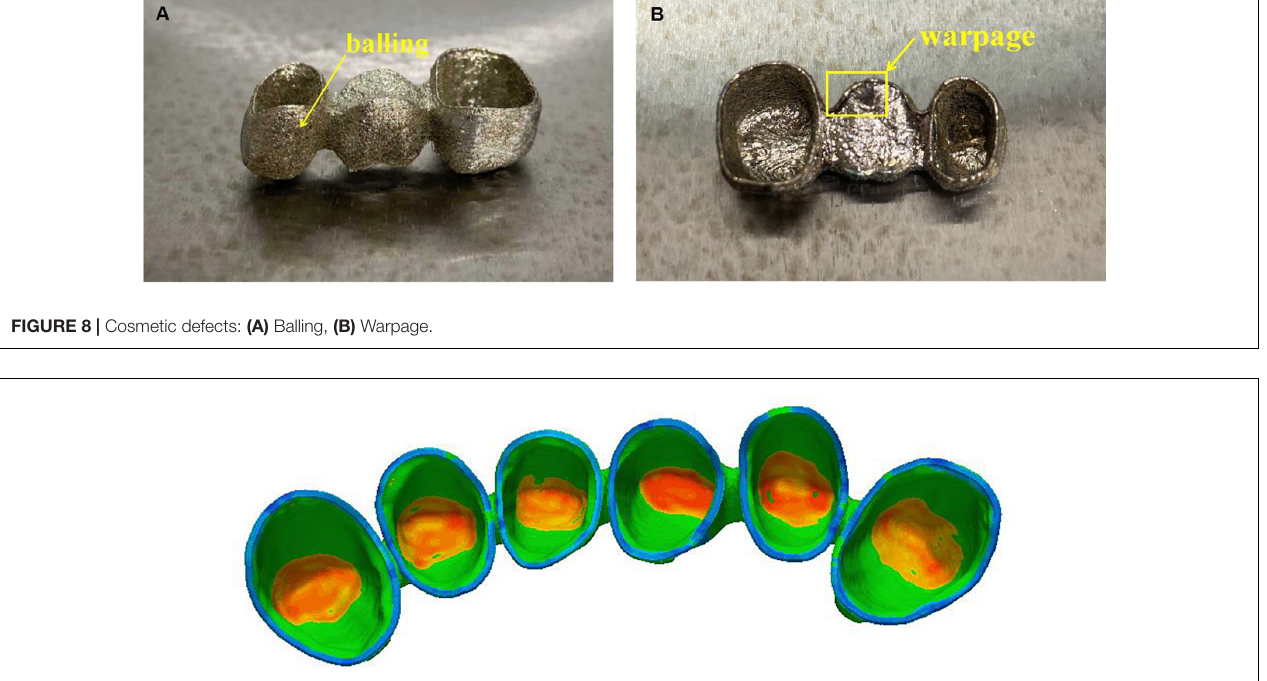
FIGURE 9 | The green surface in the half-bridge crown is the key area for quality